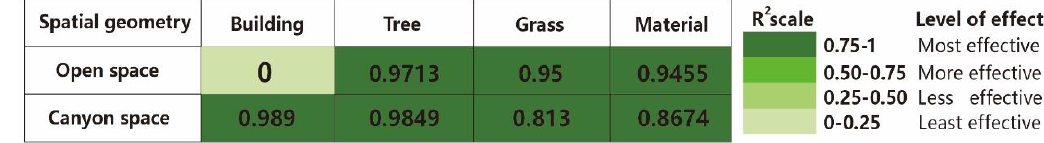
Figure 19. Correlation between different parameters and thermal comfort.